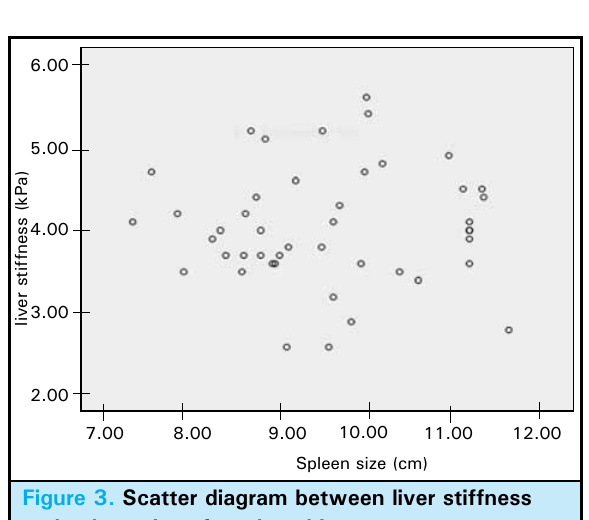
Figure 3. Scatter diagram between liver stiffness and spleen size of study subjects. table 4. Association between liver stiffness and different group of